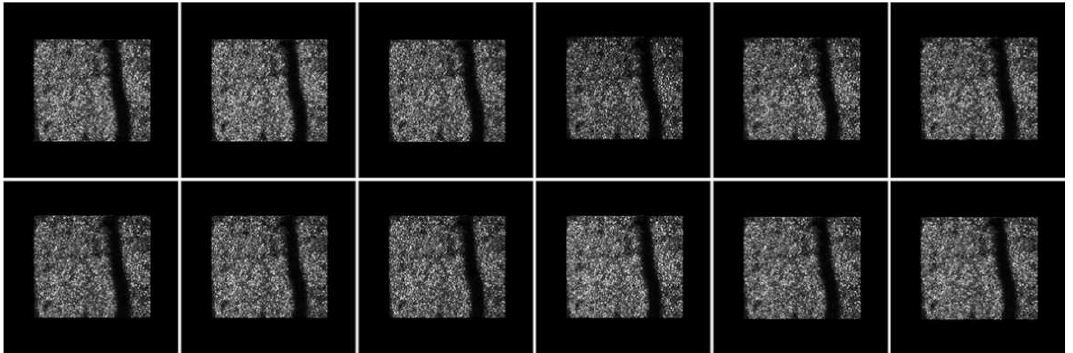
Figure 15. AOSLO image stabilization results under slow drifts. The first image is the first frame in the sequence.